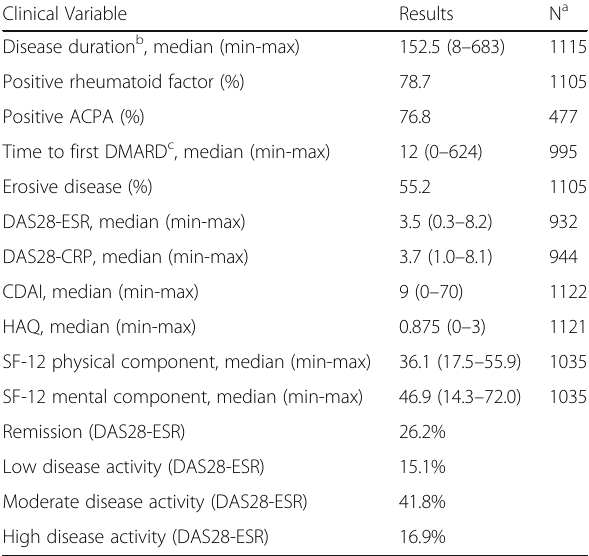
Table 2 RA patients ’ clinical characteristics in the REAL cohort Clinical Variable